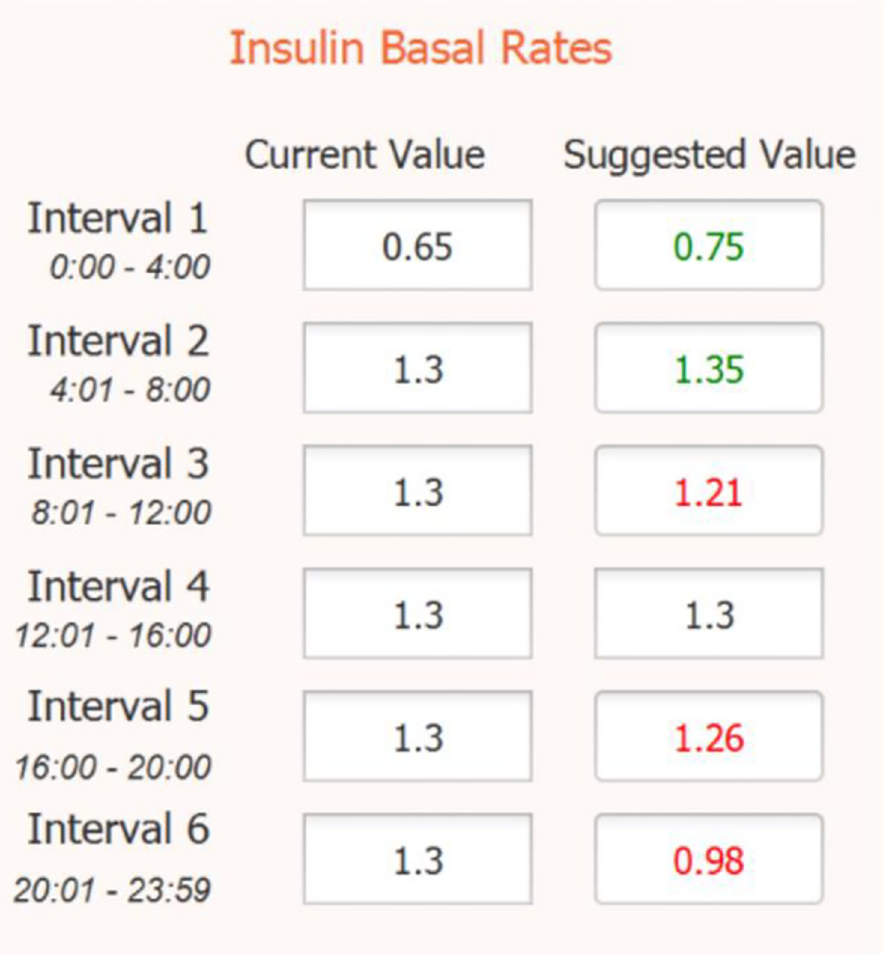
Fig 3. Algorithm insulin basal rate suggestions. Upon analyzing a 48-hour simulation run, the Fuzzy-Logic algorithm returns suggested changes to basal rates. Values displayed in green prompt the user to a necessary increase in the pump parameter, red values suggest decreasing a basal rate, and black values suggest no